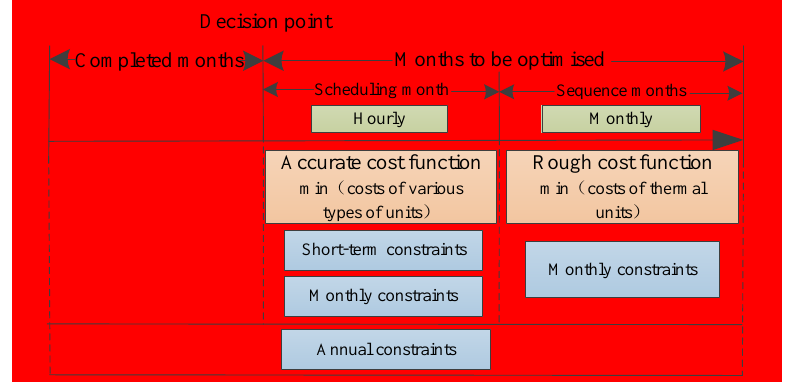
Figure 2. The monthly energy-trade scheduling model according to the improved time series simulation.